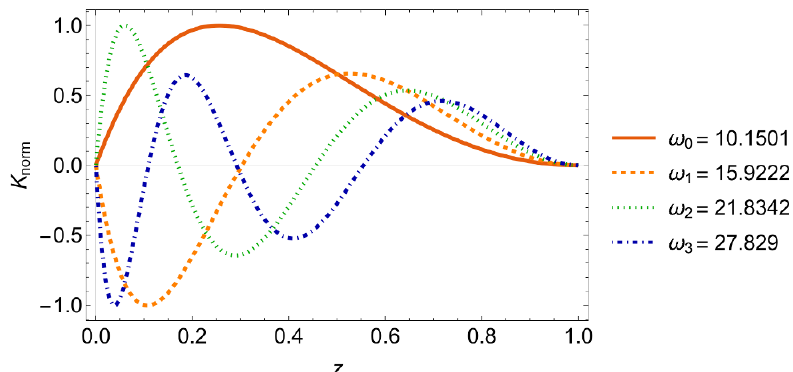
Figure 3 . Numerically obtained radial wavefunctions of the (cid:12)rst four excitation modes of an asymptotically AdS 2 (1,0,1) superstratum with b = 1, p = q 1 = q 2 = 1 and l = 2, plotted as functions of z